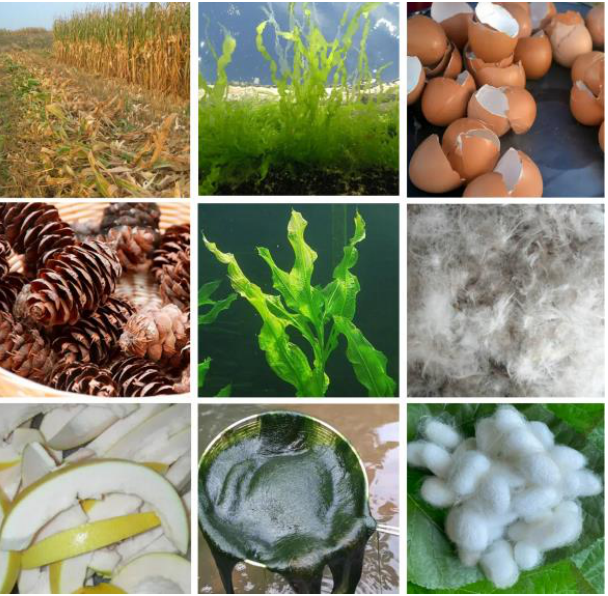
Figure 2. Various biomass produced through plant, animal, algae-based residues.